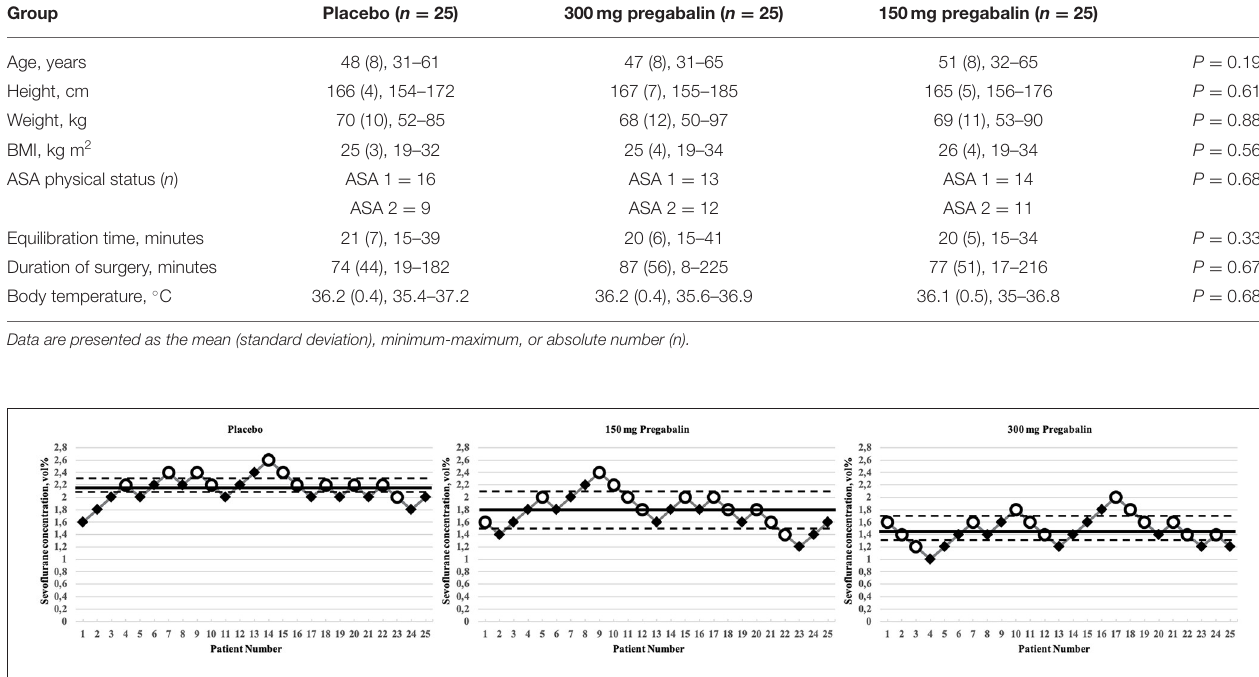
FIGURE 2 | Titration process in the study groups. Circles indicate patients who moved, and rhombi indicate patients who did not move. Solid horizontal lines indicate the bootstrap estimates for the MAC, dashed horizontal lines indicate the 95% confidence intervals. MAC, minimum alveolar concentration.